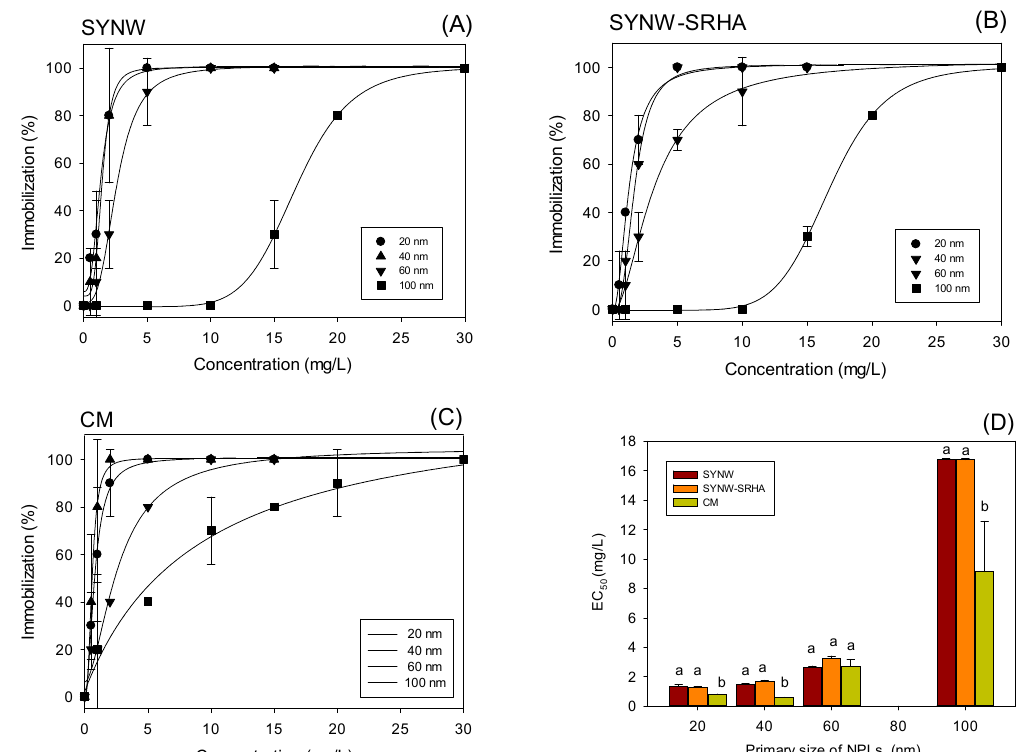
Figure 4. Immobilization of D. magna as a function of NPL concentration obtained in ( A ) synthetic medium, ( B ) synthetic medium with 1 mg/L SRHA added, and ( C ) D. magna culture medium. The lines represent the fit of experimental data with a four-parameter log-logistic model. Error bars represent the standard deviation when bigger than the symbol size, N = 3. ( D ) Acute EC 50 values for D. magna , 48-h immobilization exposed to NPLs of different primary sizes obtained in synthetic media. The values are average ± standard deviation for triplicate experiments (N = 3). Letters indicate statistically significant difference between treatments (all pairwise multiple comparison procedures—Tukey’s test within each group, p -value < 0.05).